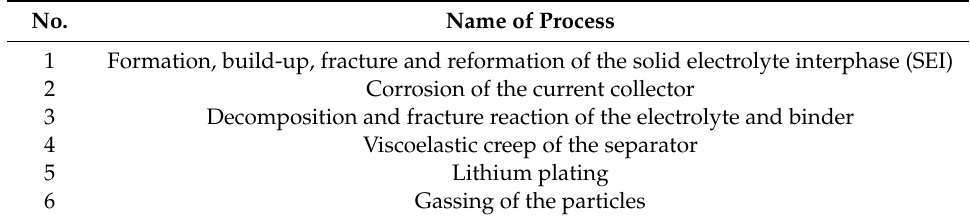
Table 1. Main aging processes taking place in lithium-ion cells (Adapted from [24]).